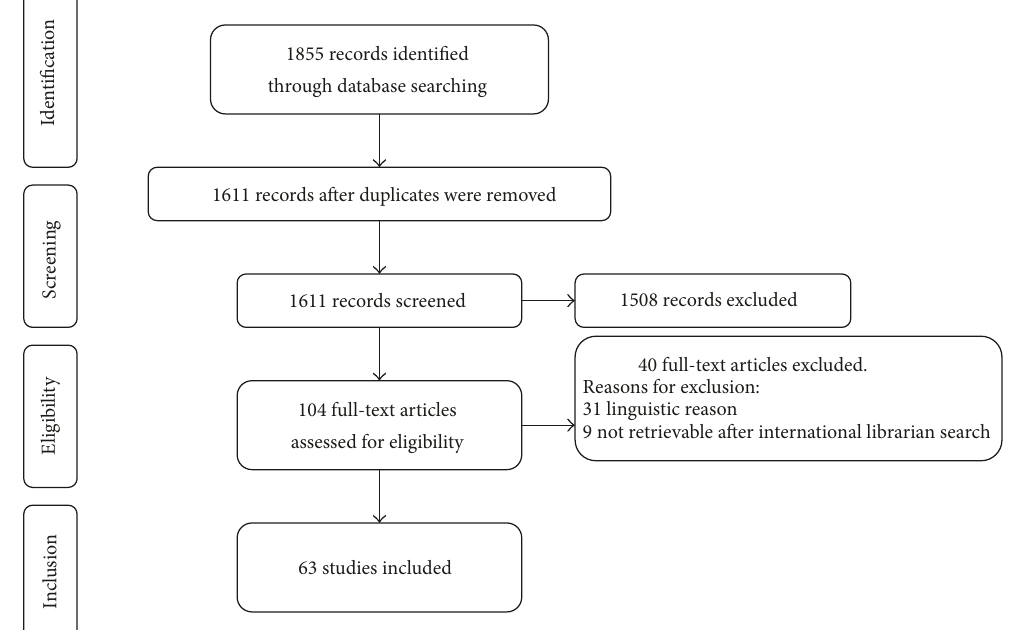
Figure 2: Study selection